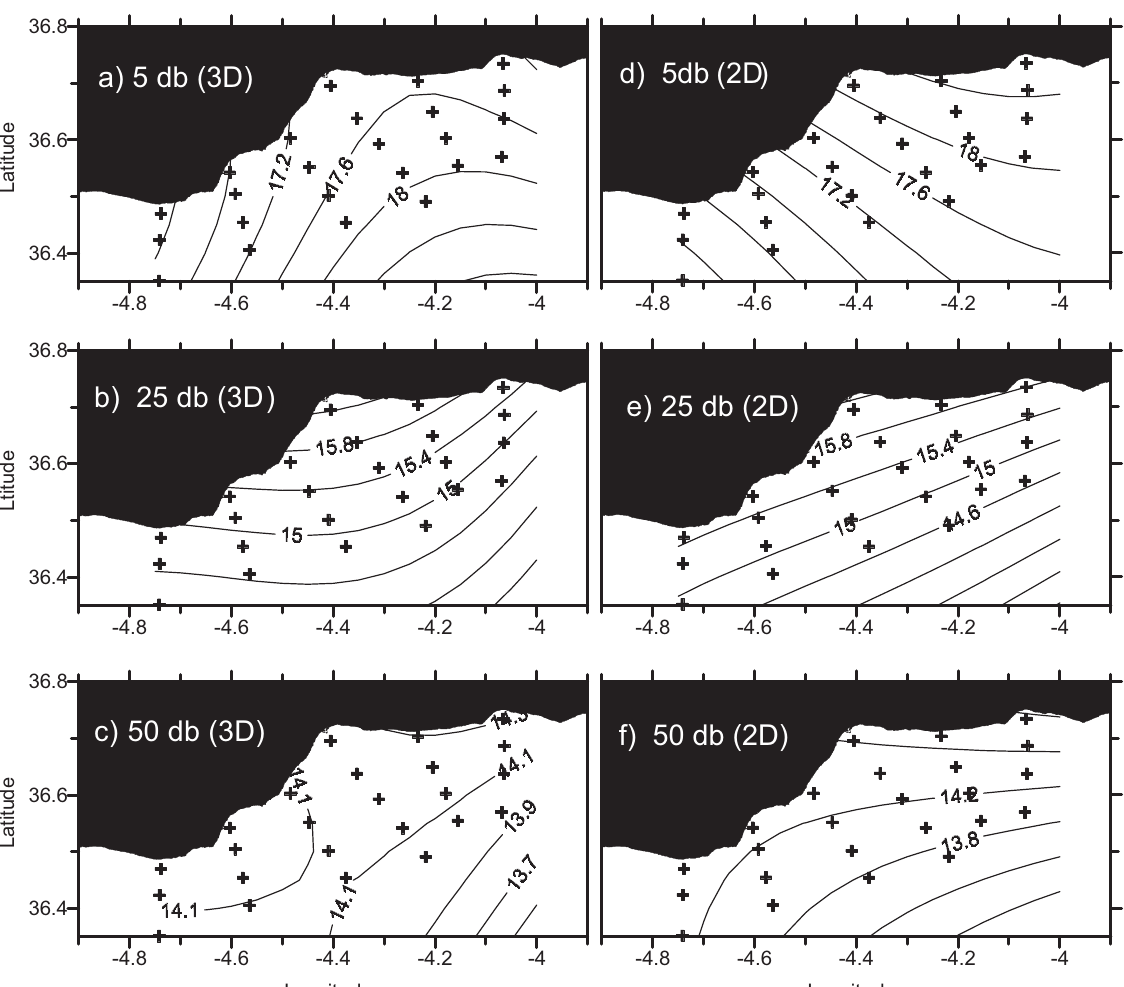
F IG . 8. – Temperature interpolated fields from the Ecomálaga 0703 survey. Cast positions are indicated with crosses. Figures a, b and c rep- resent three horizontal sections at 5, 25 and 50 db from the three dimensional interpolation. Figures d, e, f are the same sections from a two- dimensional interpolation at those